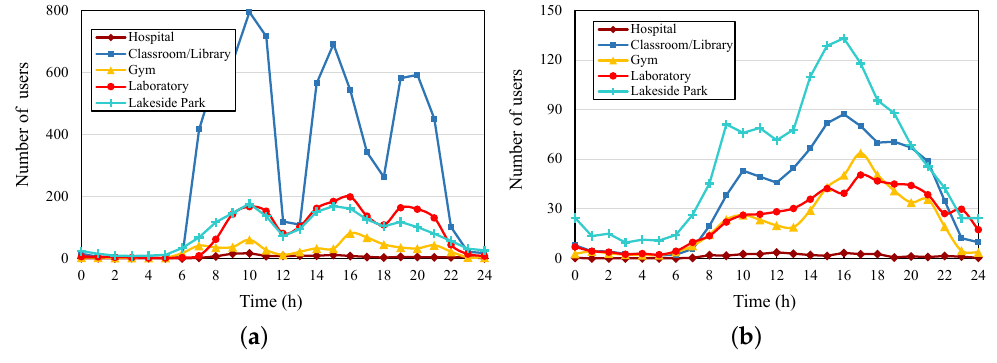
Figure 7. The average number of connected users (24 h). ( a ) Weekday; ( b ) Fig. 3. The average number of connected users (24h): Fig. 3. The average number of connected users (24h):